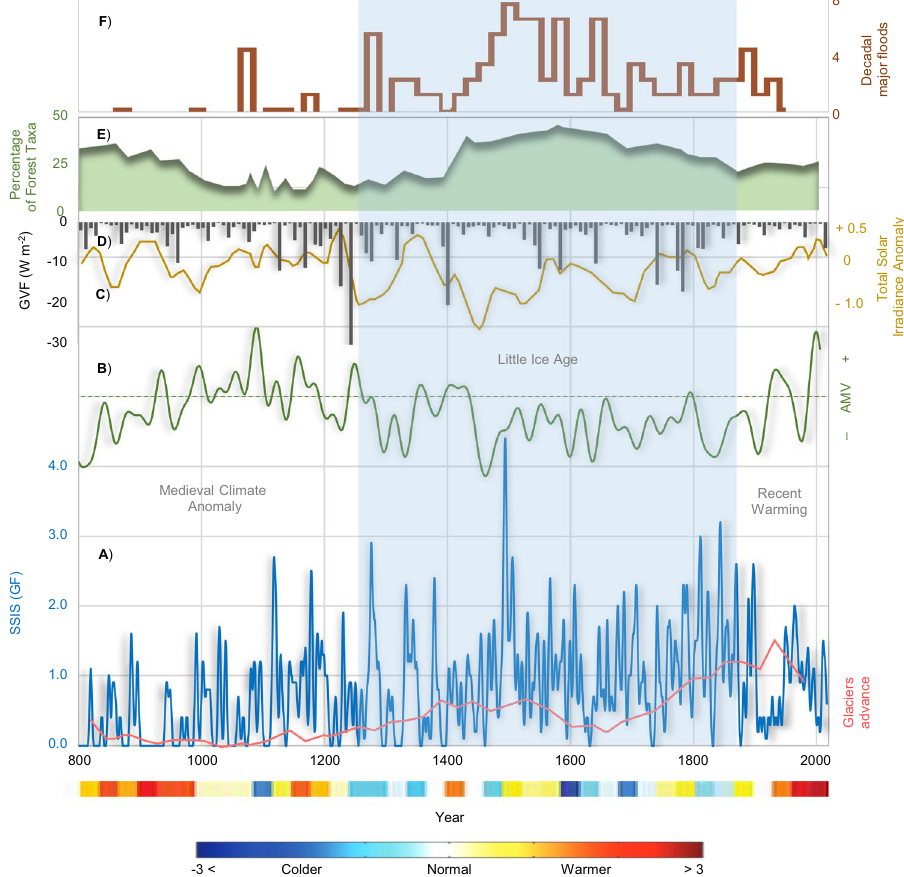
Figure 3. Overview of several environmental and climate patterns during the past twelve centuries (800–2017). ( A ) Evolution of the smoothed 11-year Gaussian filter of storm severity index sum – SSIS(GF) – in Italy (blue curve) with retreat/advance of the Langjökull glacier (Iceland) reconstructed from the Hvítárvatn lake varves 96 (red curve). ( B ) Atlantic Multidecadal Variability (AMV, green curve) 45 . ( C ) Total solar irradiance anomaly from the value of the Physikalisch-Meteorologisches Observatorium Davos (PMOD) composite during the solar cycle minimum of the year 1986 (1365.57 W m –2 ) 51 . ( D ) Global volcanic forcing 53 . ( E ) Percentage arboreal pollen record (green shape) averaged between central and southern Italy 46,97 , respectively, and ( F ) Hydrological variability for the Po River Basin (brown curve) reconstructed by foraminiferal δ 18 O record-sediment core 33 . The coloured bands of surface air temperature anomalies with regard to the 1961–1990 climate baseline for Europe 61 , at the